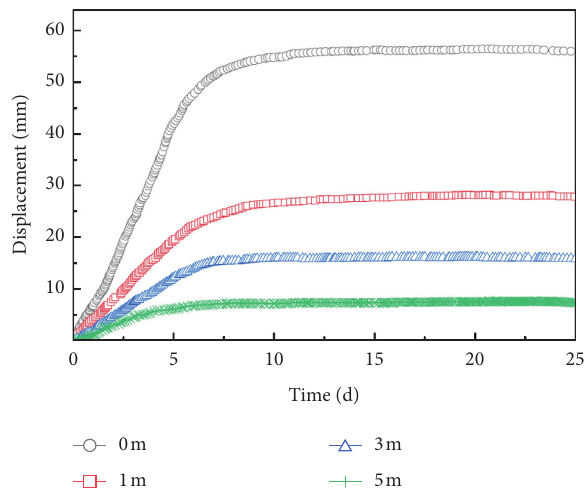
Figure 18: Displacement-time variation curves obtained by using the multipoint extensometer M